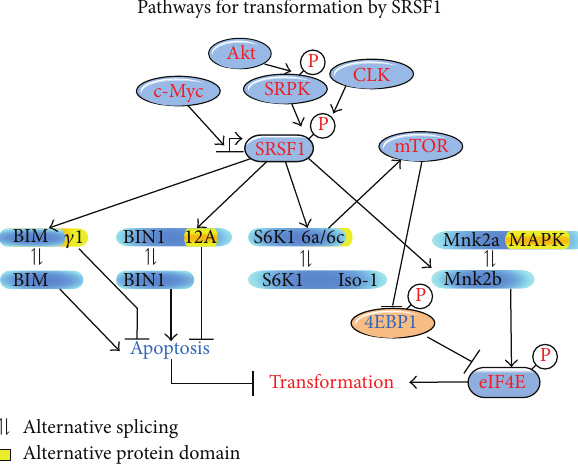
Figure 3: Pathways for transformation by SRSF1. SRSF1 is a transcriptional target of the c-myc protooncogene and can be phosphorylated by SRPK or CLK downstream to Akt. SRSF1 alters thesplicingofBIM,BIN1,S6K1,andMnk2regulatingthemTORand MAPK pathways, increasing translation, and inhibiting